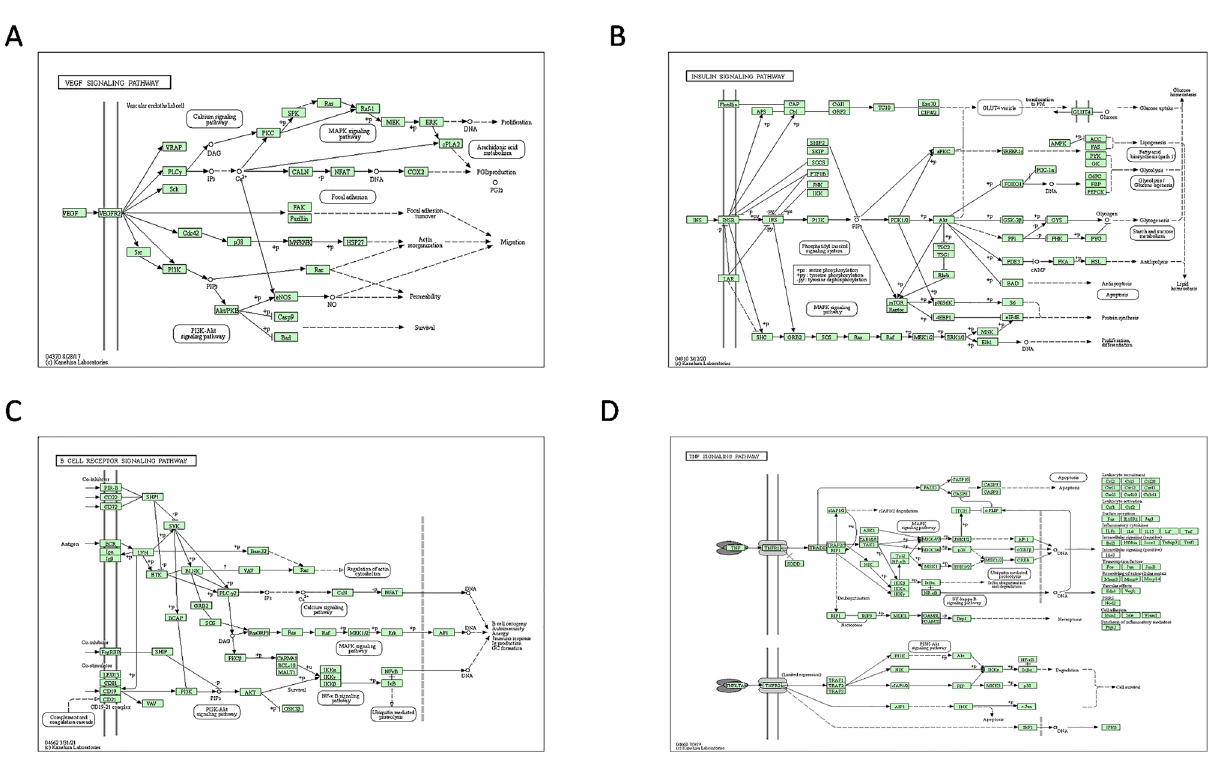
Figure 4. The four key signal path maps are from the KEGG database. (https:// www. kegg. jp/ kegg/ kegg1. html). VEGF signaling pathway map ( A ). Insulin signaling pathway map ( B ). B cell receptor signaling pathway map ( C ). TNF signaling pathway map ( D